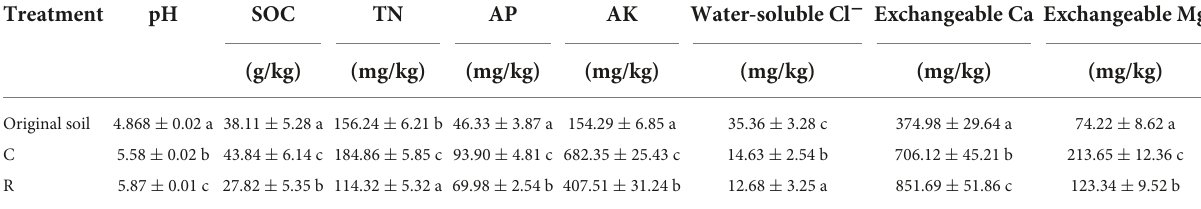
TABLE 1 Soil physicochemical properties of different cropping systems.